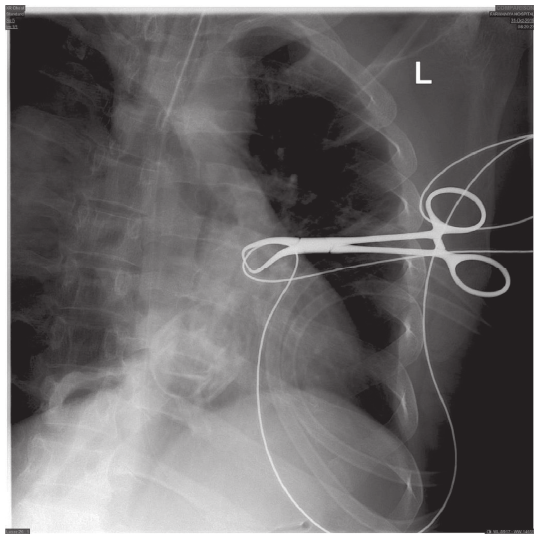
Figure 5: Intraoperative chest radiograph after insertion of in- tercostal tube showing normal lung